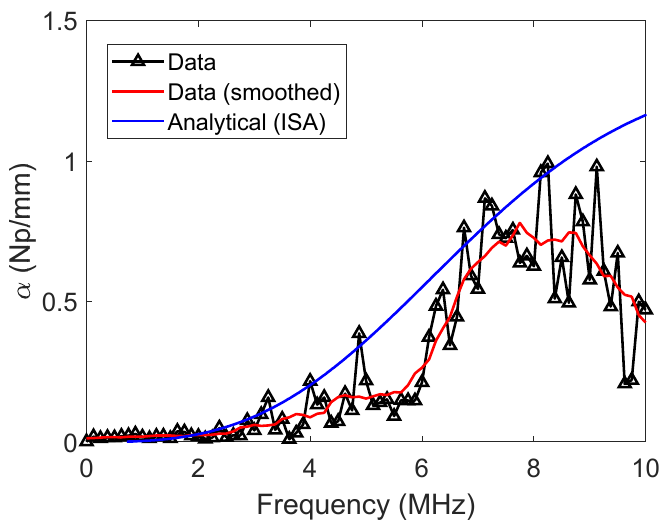
Figure 5. Coherent wave attenuation for the 1% volume fraction case. An analytical attenuation curve computed using independent scattering approximation (ISA) is displayed as a reference. A smoothed coherent wave attenuation curve obtained by applying moving averaging is also displayed.